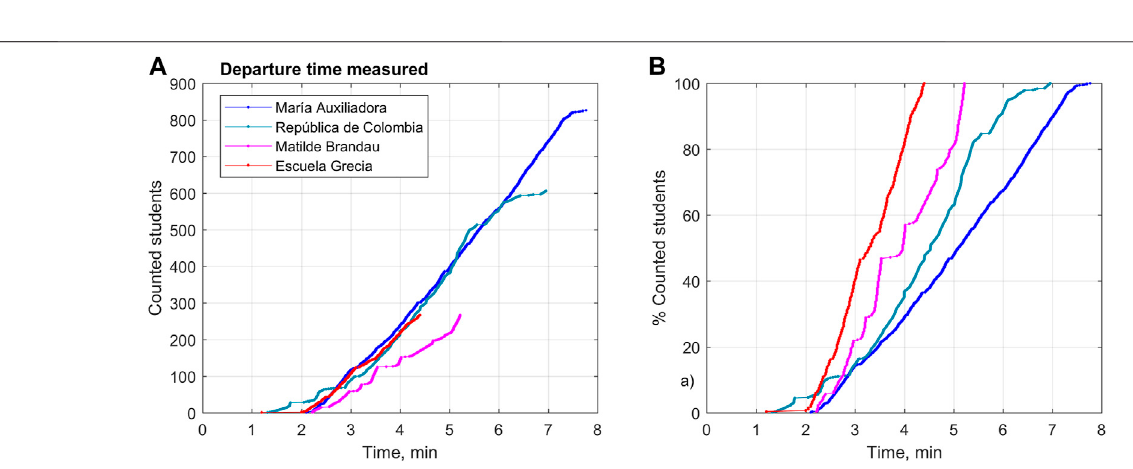
FIGURE 3 | Departure time of the four examined